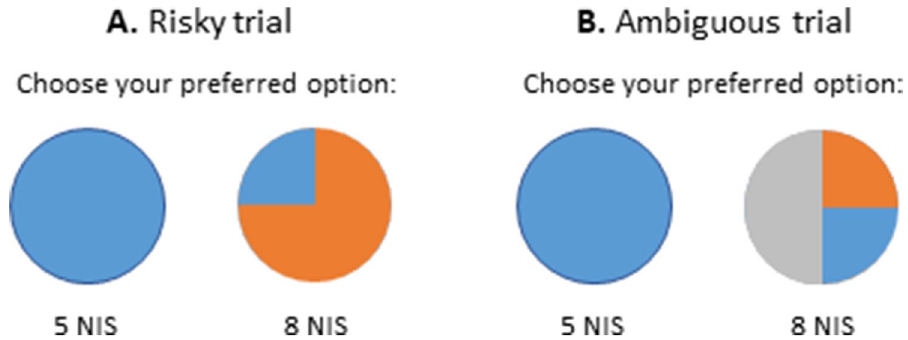
Figure 1. Risk and ambiguity task. Examples of risky ( A ) and ambiguous ( B ) choice trials in the risk and ambiguity